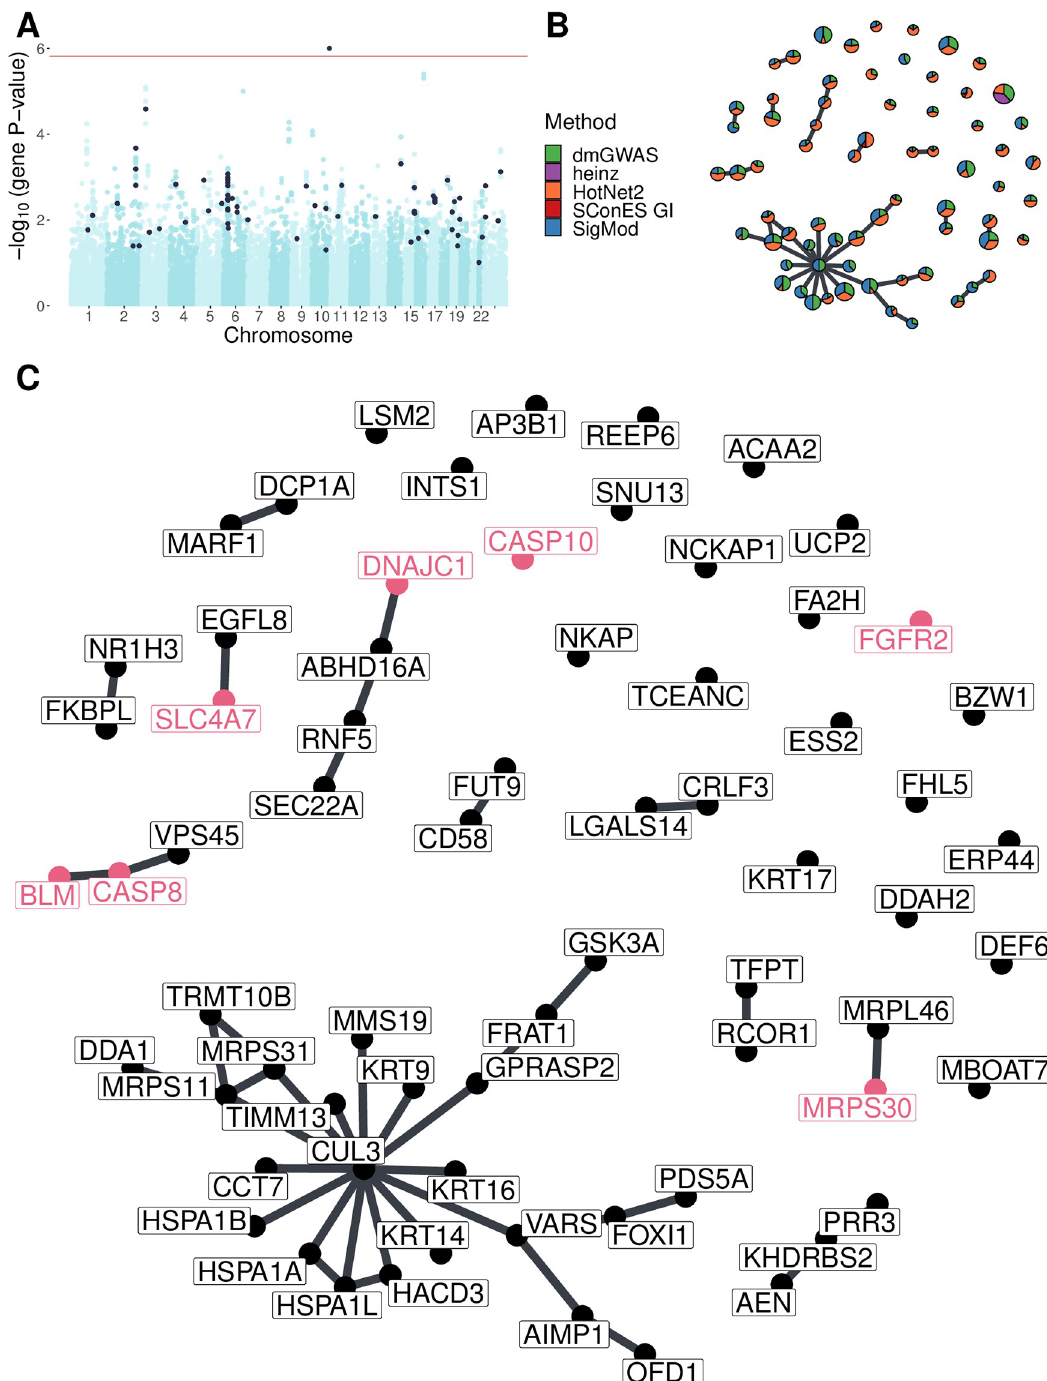
Fig 5. Stable consensus solution on GENESIS (Section 3.8). (A) Manhattan plot of genes; in black, the ones in the stable consensus solution. The red line indicates the Bonferroni threshold (1.53 × 10 -6 for genes). (B) Stable consensus network. Each gene is represented by a pie chart, which shows the methods that selected it. We enlarged the most central gene ( CUL3 ), the known breast cancer susceptibility genes, and the BCAC-significant genes (Section 2.6). (C) The nodes are in the same disposition as in panel B, but we indicated every gene name. We colored in pink the names of known breast cancer susceptibility genes and BCAC-significant genes.